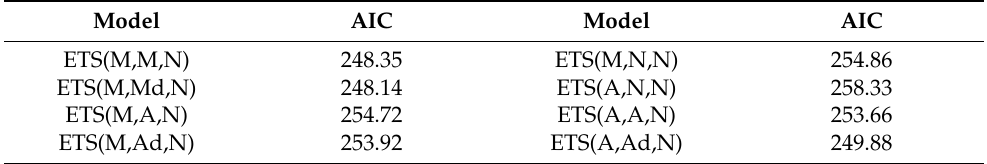
Table 5. Overview of ETS